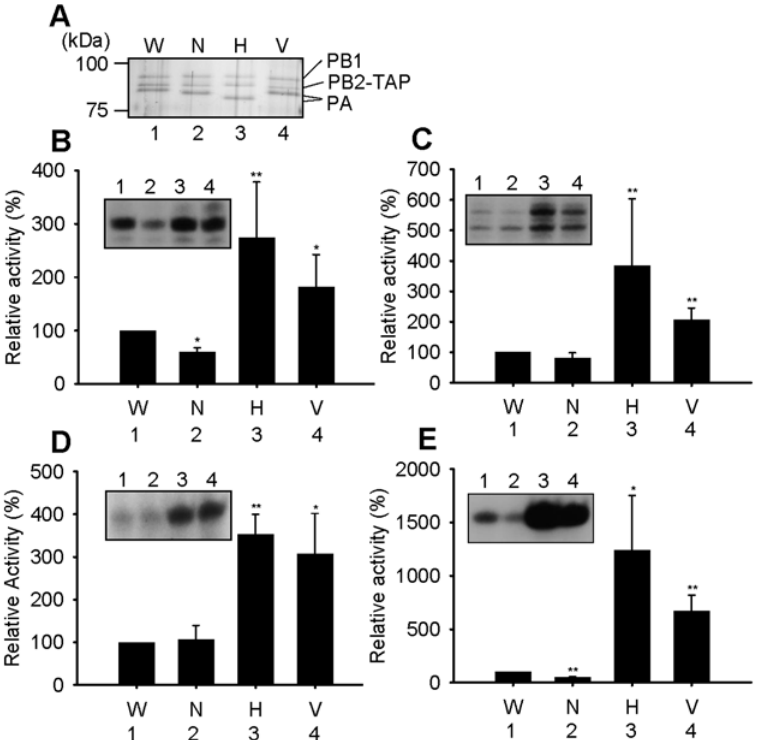
Figure 1. Comparison of polymerase activities of two H5N1 strains and two classical human strains in vitro. (A) 7.5% SDS-PAGE of WSN (W), NT (N), HK (H) and VN (V) partially purified polymerases analysed by silver staining. The positions of PB1, PB2-TAP and the variable positions of PA are indicated. (B) ApG-primed transcription of W, N, H & V polymerases (see Materials and Methods). (C) Globin mRNA-primed transcription of W, N, H & V polymerases (see Materials and Methods). (D) ApG synthesis with a model vRNA promoter and (E) with a model cRNA promoter of W, N, H & V polymerases (see Materials and Methods). Relative activity is % activity relative to WSN (W) from at least 3 independent experiments. Inset square panels in B–E show typical results. * and ** show statistical significance at p , 0.05 and p , 0.01, respectively, in a Student’s